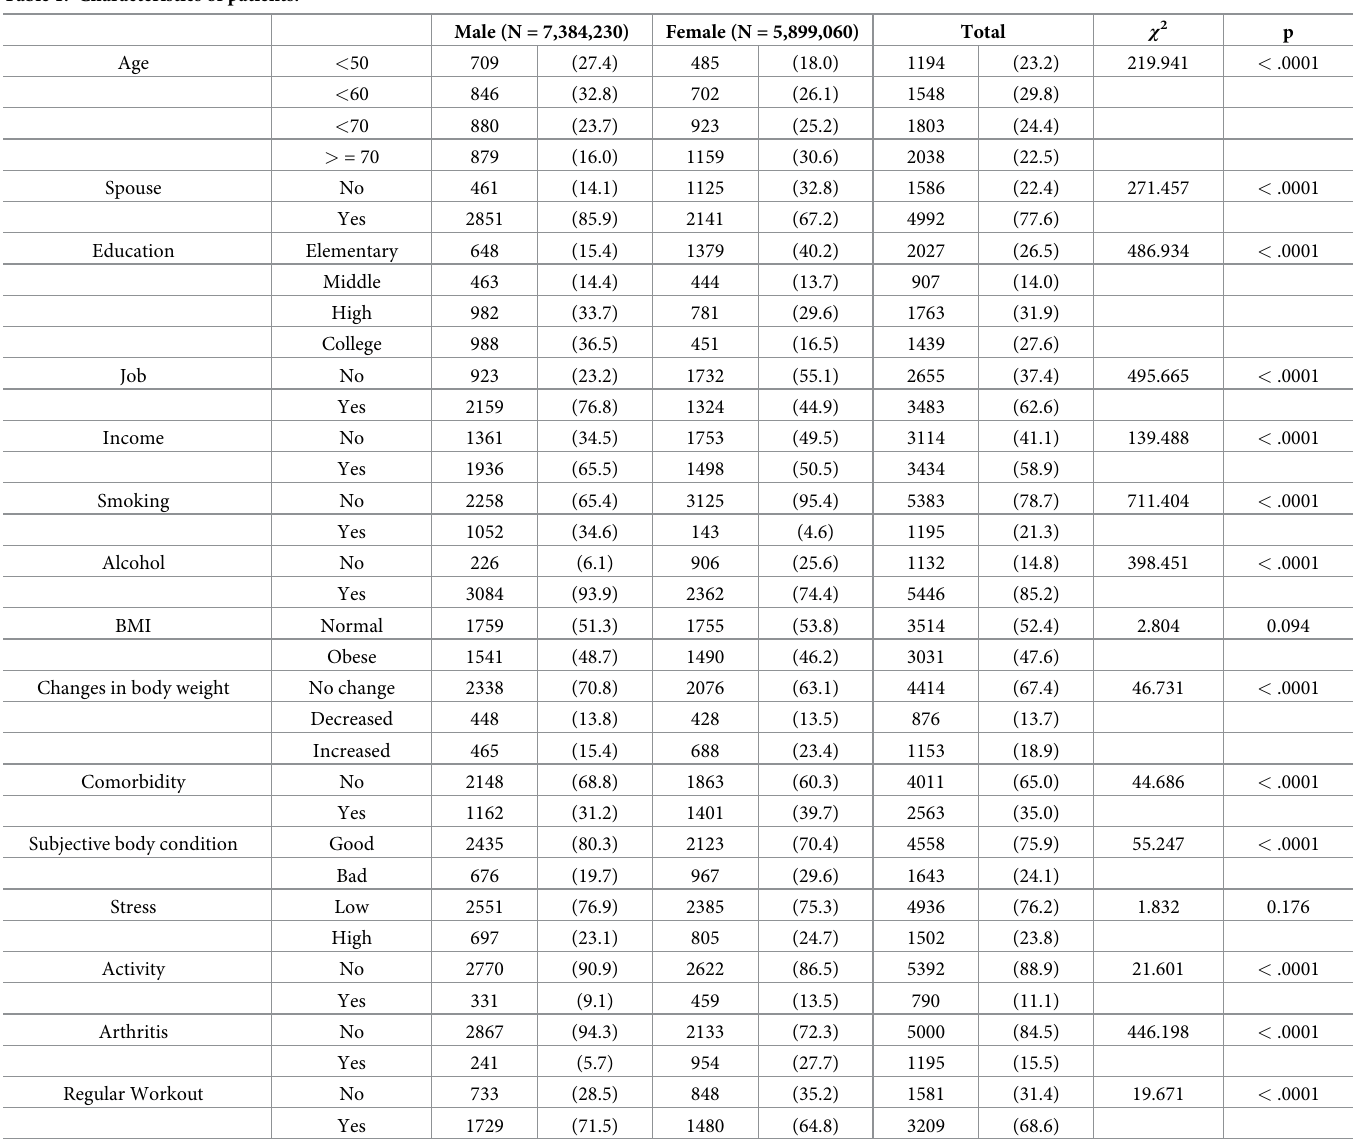
Table 1. Characteristics of